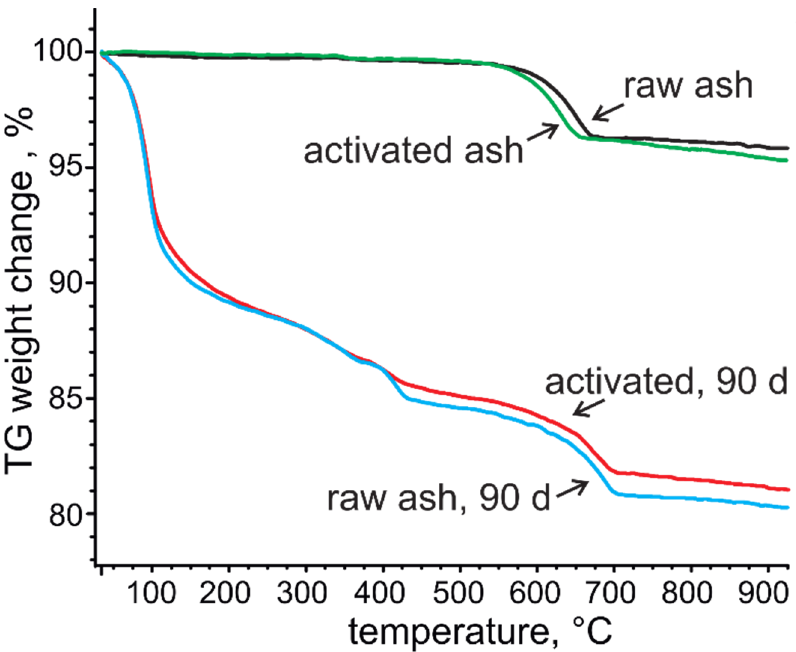
Figure 9. Representative curves of thermogravimetric (TGA) analysis of raw and mechanically activated ash and pastes with raw ash, and activated ash (4 min) after 90 days of curing.